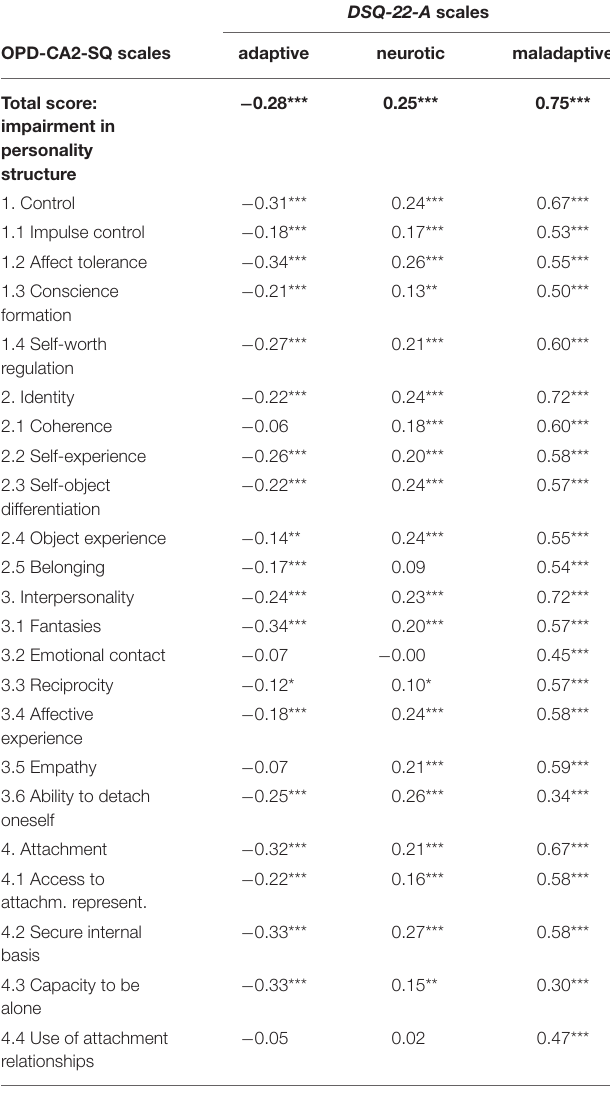
TABLE 5 | Pearson correlation ( r ) of the DSQ-22-A scales with all scales and subscales of